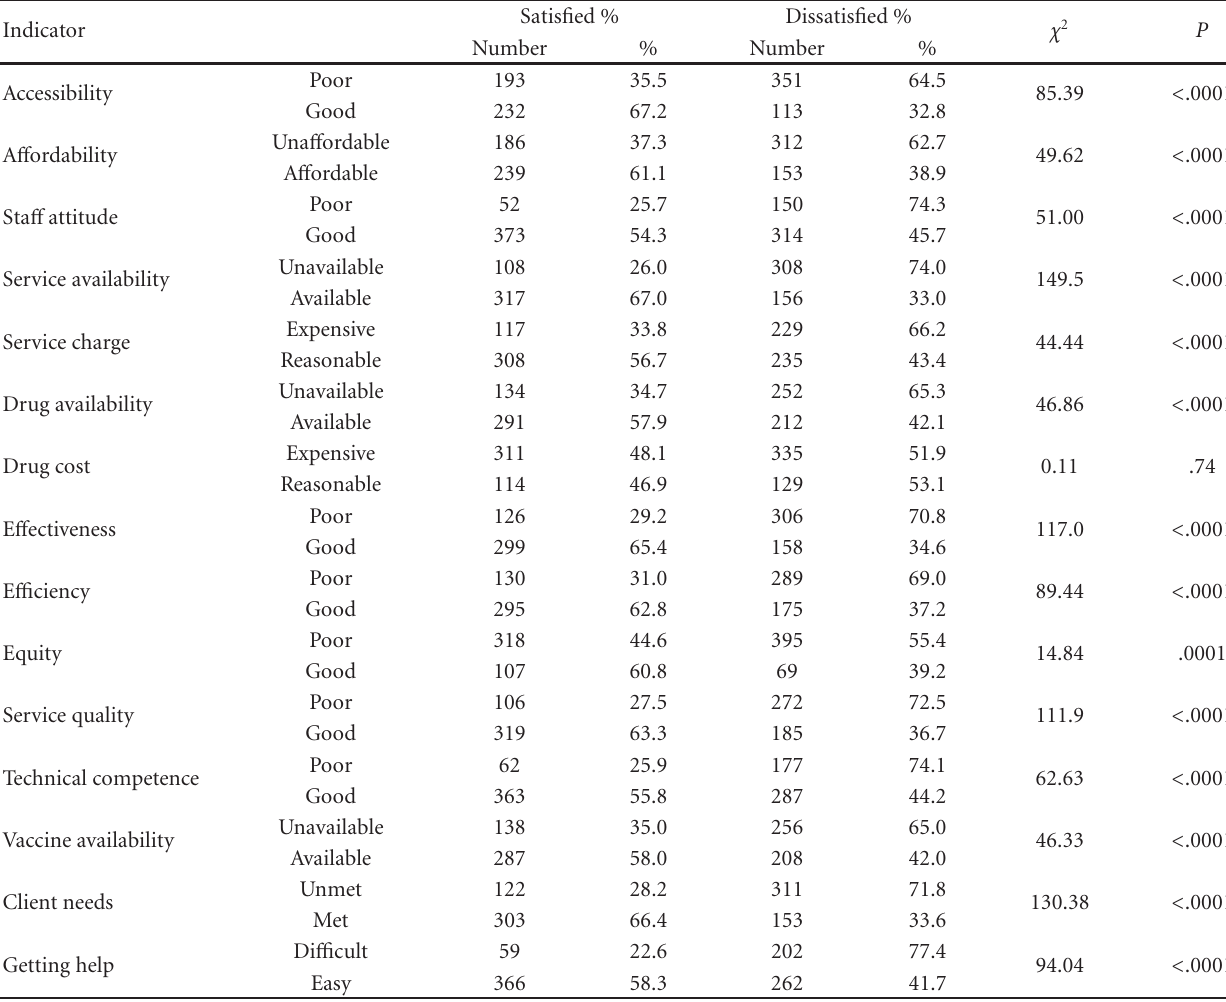
Table 1: Indicators of quality of delivery of veterinary services in Ghana.